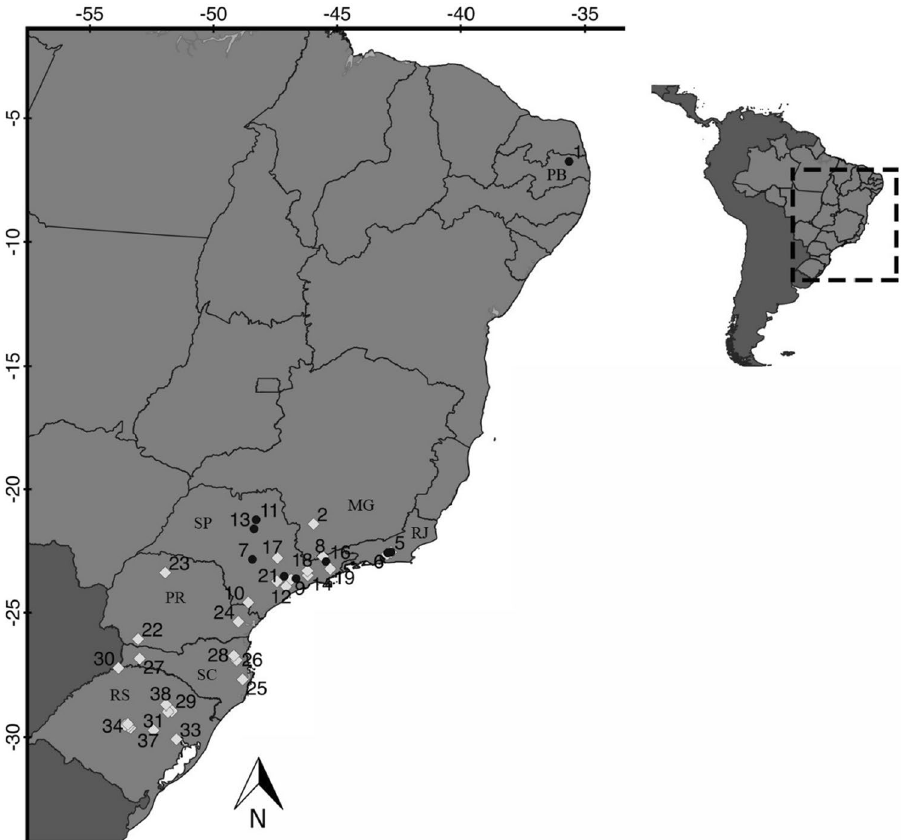
Figure 1. Sampling locations of bullfrogs in Brazil. Include captive (circle) and feral (diamond) specimens. Sample size is reported in parentheses. 1. Bananeiras, Universidade Federal de Paraíba frog farm (22); 2. Alfenas (21); 3. Magé, Vila Pedrinhas frog farm (16); 4. Cachoeira de Macacu (10); 5. Cachoeira de Macacu, Andre’s frog farm (16); 6. Guapimirim, Romar frog farm (25); 7. Botucatu, Universidade Estadual de São Paulo (UNESP) frog farm (20); 8. Campos do Jordão (4); 9. Embu das Artes (4); 10. Iporanga (1); 11. Jaboticabal, UNESP frog farm (4); 12. Juquitiba (1); 13. Matão, Ranamat frog farm (10); 14. Mogi das Cruzes (5); 15. Piedade (9); 16. Pindamonhangaba, Vale sereno frog farm (7) ; 17. Santa Barbara D’oeste, Santa Rosa frog farm (3); 18. Santa Isabel, Santa Clara frog farm (4); 19. São Luiz do Paraitinga (3); 20. São Paulo, Santa fé frog farm (3); 21. São Roque, Ranaville (9); 22. Francisco Beltrão (15); 23. Maringá (16); 24. Quatro Barras (5); 25. Águas Mornas (1); 26. Blumenau (2); 27. Pinhalzinho (1); 28. Pomerode (5); 29. Cotipora (1); 30. Derrubadas (7); 31. Dois Lageados (1); 32. Dona Francisca (1); 33. Eldorado do Sul (2); 34. Faxinal do Soturno (26); 35. Ivora (2); 36. Nova Palma (16); 37. Santa Cruz do Sul (25); 38. Serafina Correa (1). States where bullfrog samples are represented with their initials: Paraíba (PB), Rio de Janeiro (RJ), Minas Gerais (MG), São Paulo (SP), Paraná (PR), Santa Catarina (SC), and Rio Grande do Sul